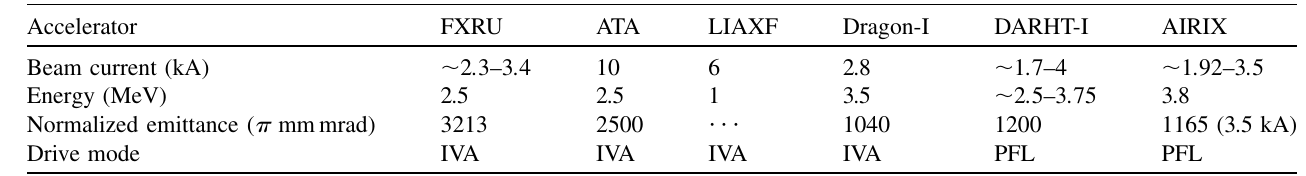
TABLE IV. Properties of injectors for LIA